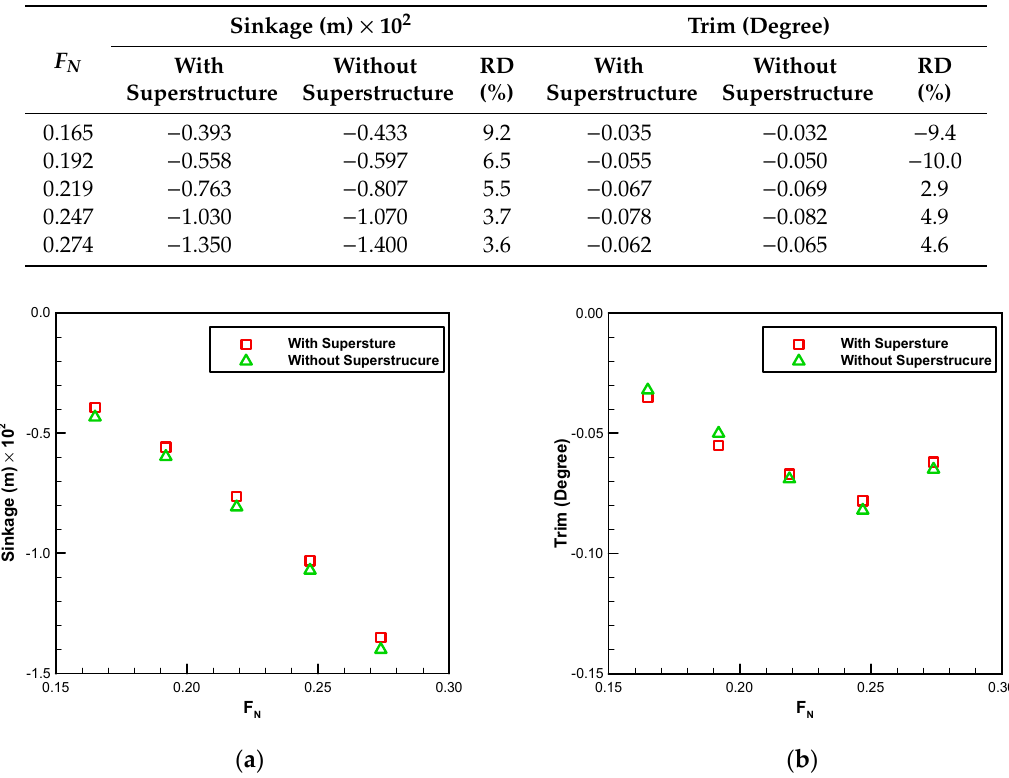
Table 4. Comparison of the simulation results with and without a superstructure (RD—relative difference).